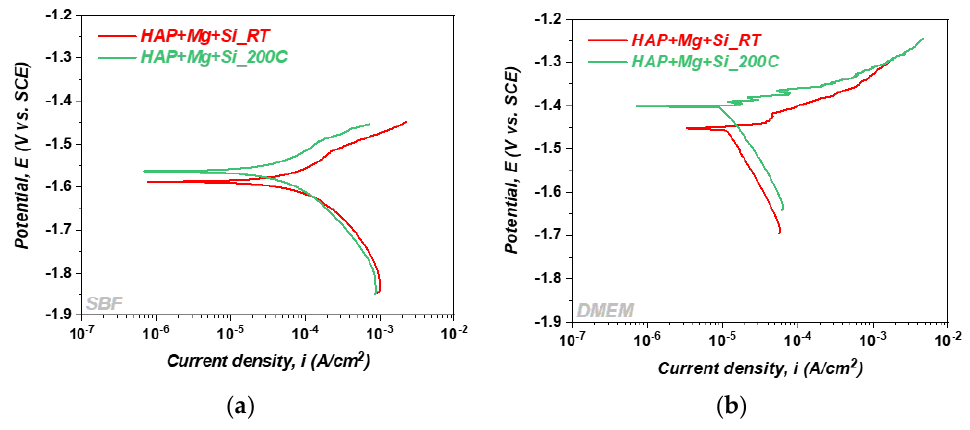
Figure 5. In vitro Tafel results: ( a ) Tests in SBF solution; ( b ) Tests in DMEM solutions. Table 3. Electrochemical parameters of the coatings obtained in SBF and DMEM solutions. Coatings